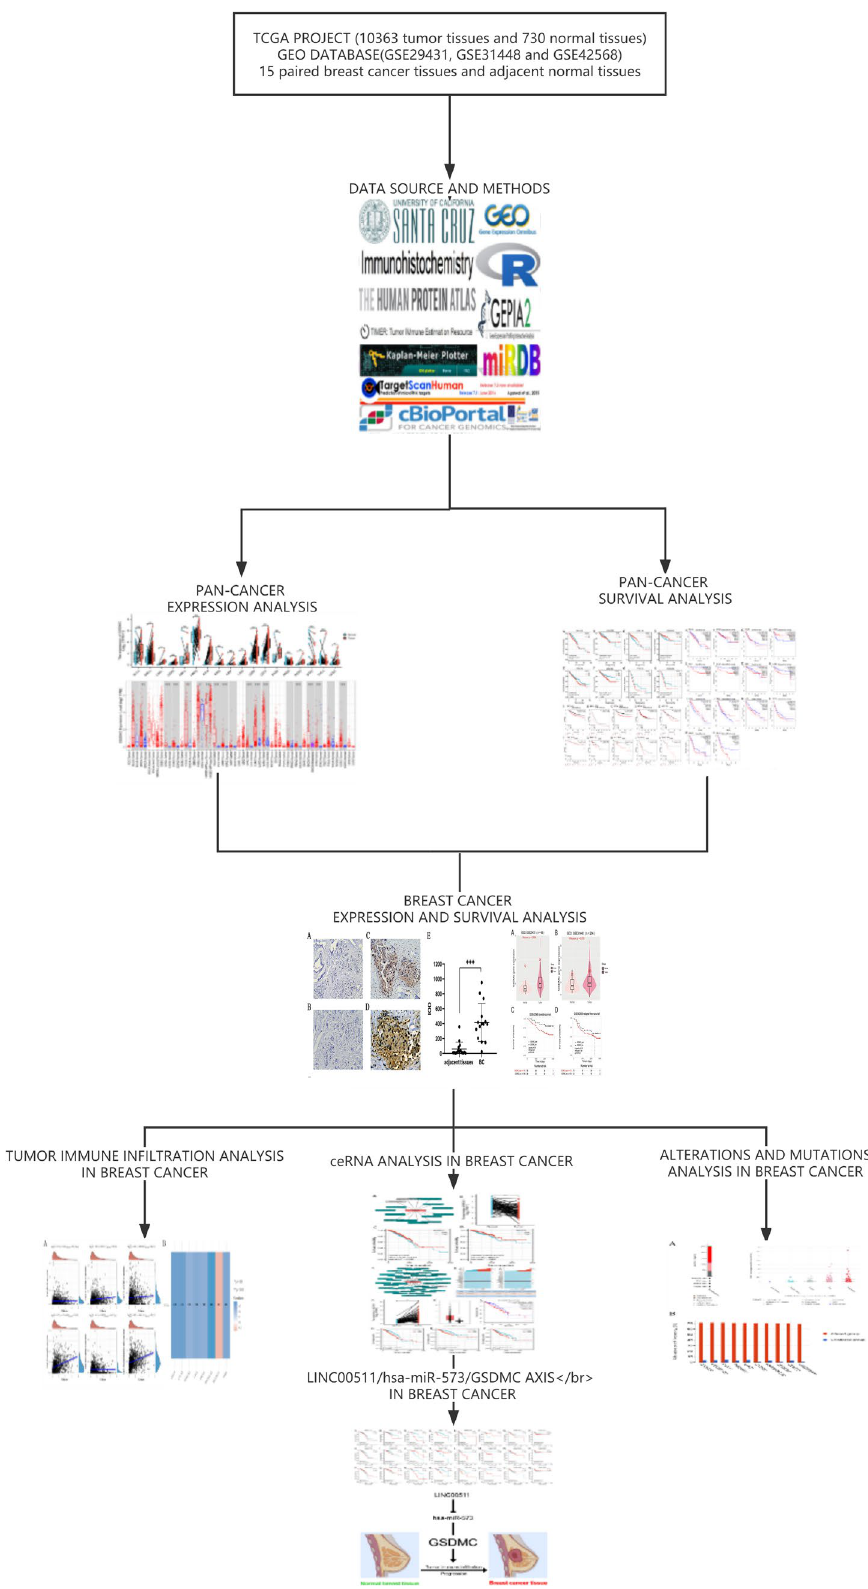
Figure 1. Analysis workflow and results of this